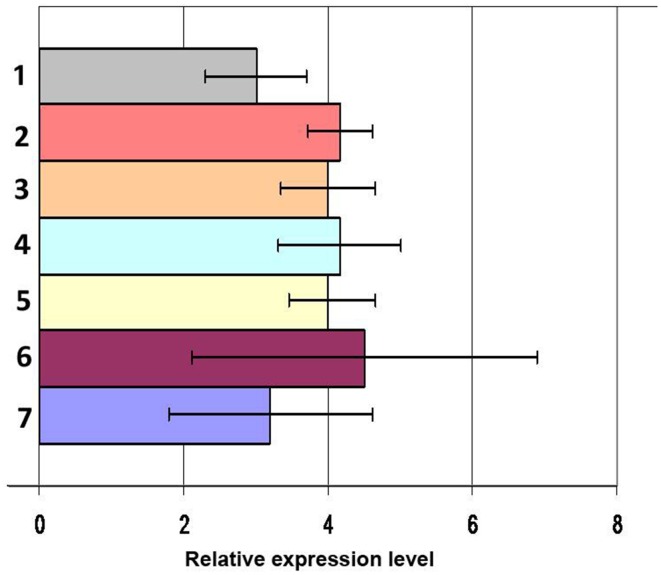
mRNA expression levels of arenicin-1 measured by RT-PCR relatively to actin in coelomocytes after immunization. Microbial mixture 24 h post infection (1), C. albicans 24 h post infection (2), E. coli 48 h (3) and 24 h post infection (4), L. monocytogenes 24 h post infection (5), PBS 24 h post infection (6), intact animals (7). Data are expressed as mean ± SD.